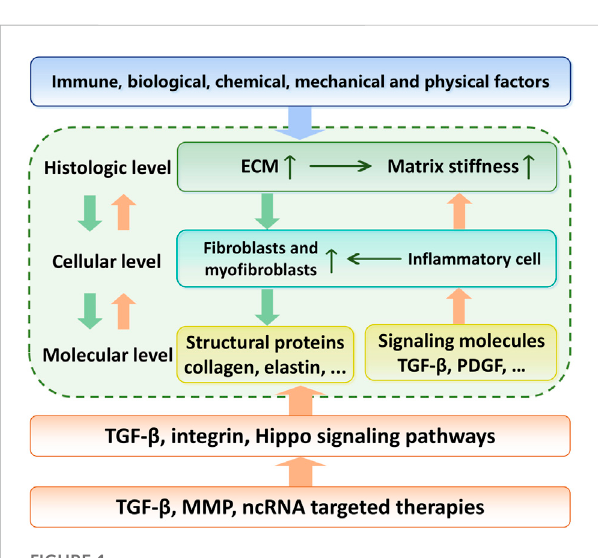
FIGURE 1 Relationship between the etiology, regulation mechanisms and targeted therapy of skin fi brosis. With environmental or genetic pathogenic factors, fi broblasts are activated and secrete large amounts of extracellular matrix. This process is further enhanced by the matrix stiffness upregulation. The TGF- β signaling pathway acts as the center of this positve feedback. Targeted therapies to break this vicious circle is a promising pathway in skin fi brosis